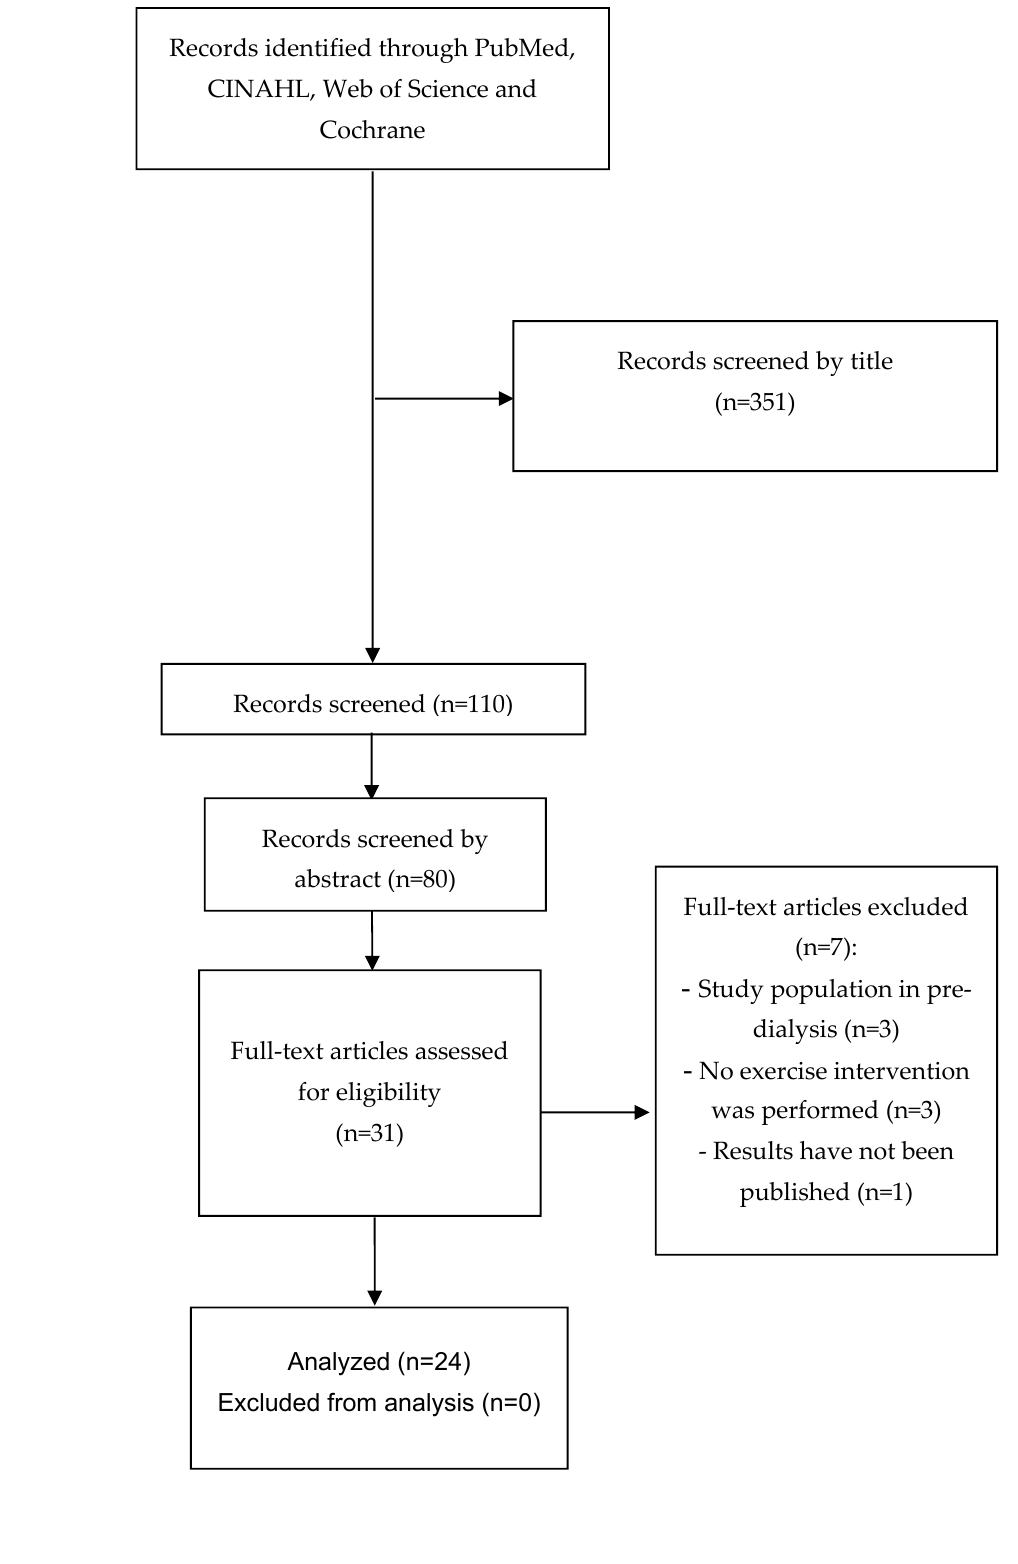
Figure 1. PRISMA Flow diagram.